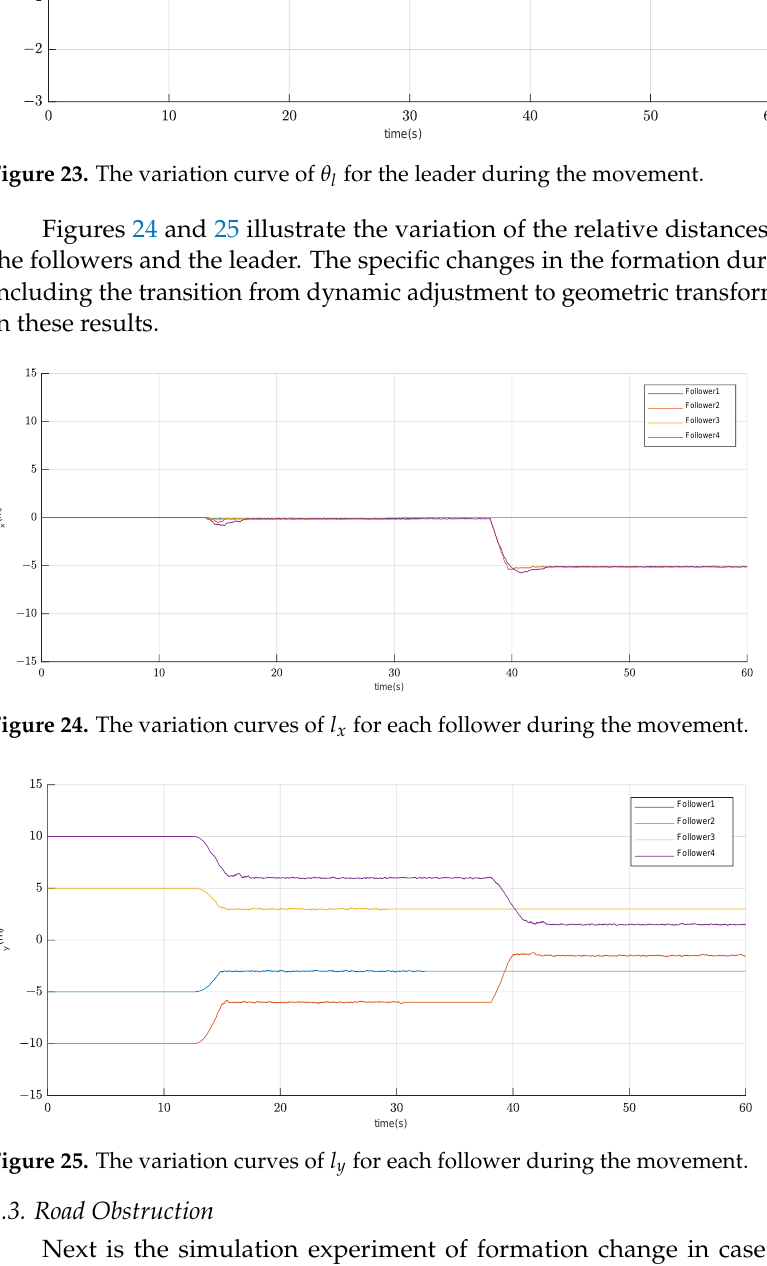
Figure 25. The variation curves of